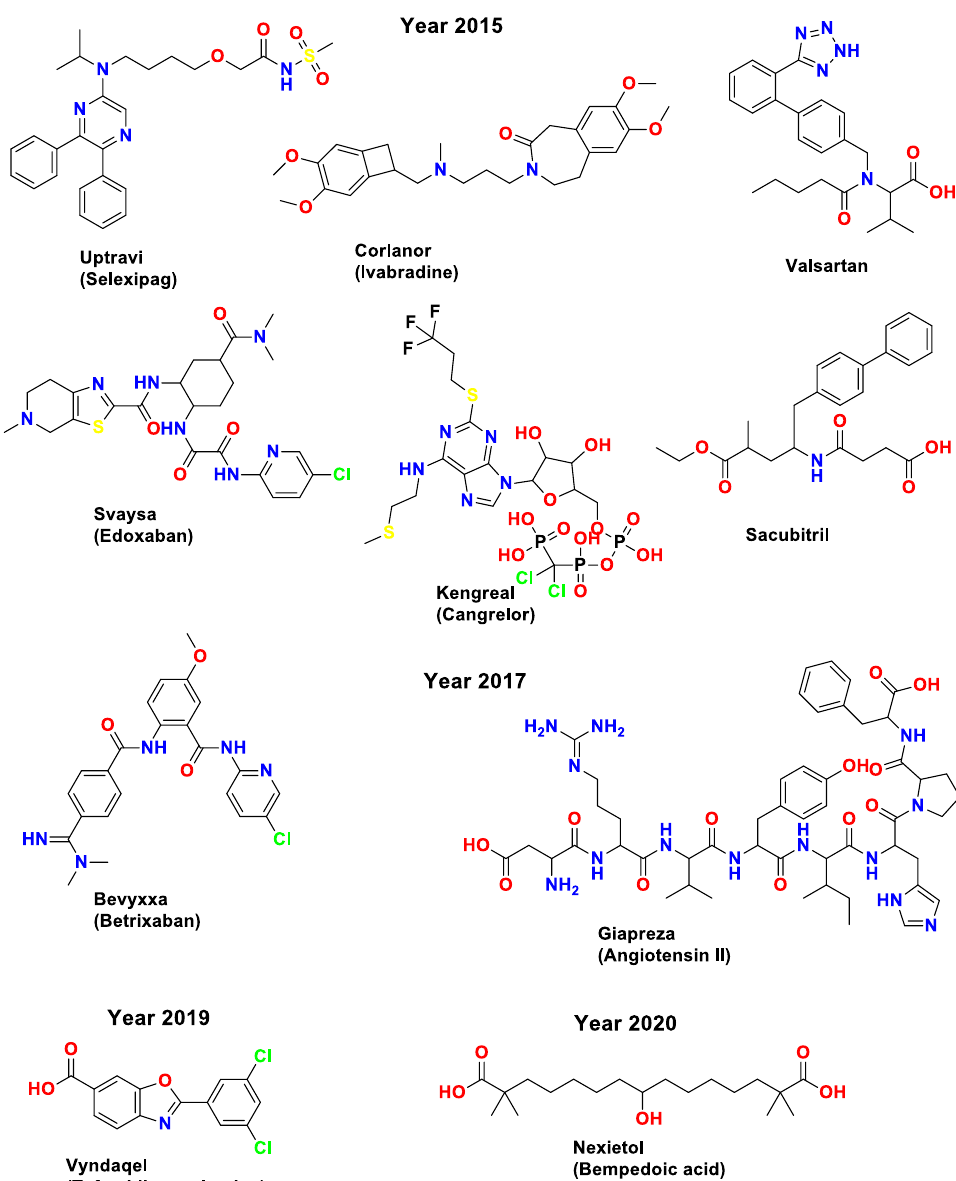
Fig.1 Chemical structures of small compounds approved by the FDA for use in treating various cardiovascular diseases between 2015 and